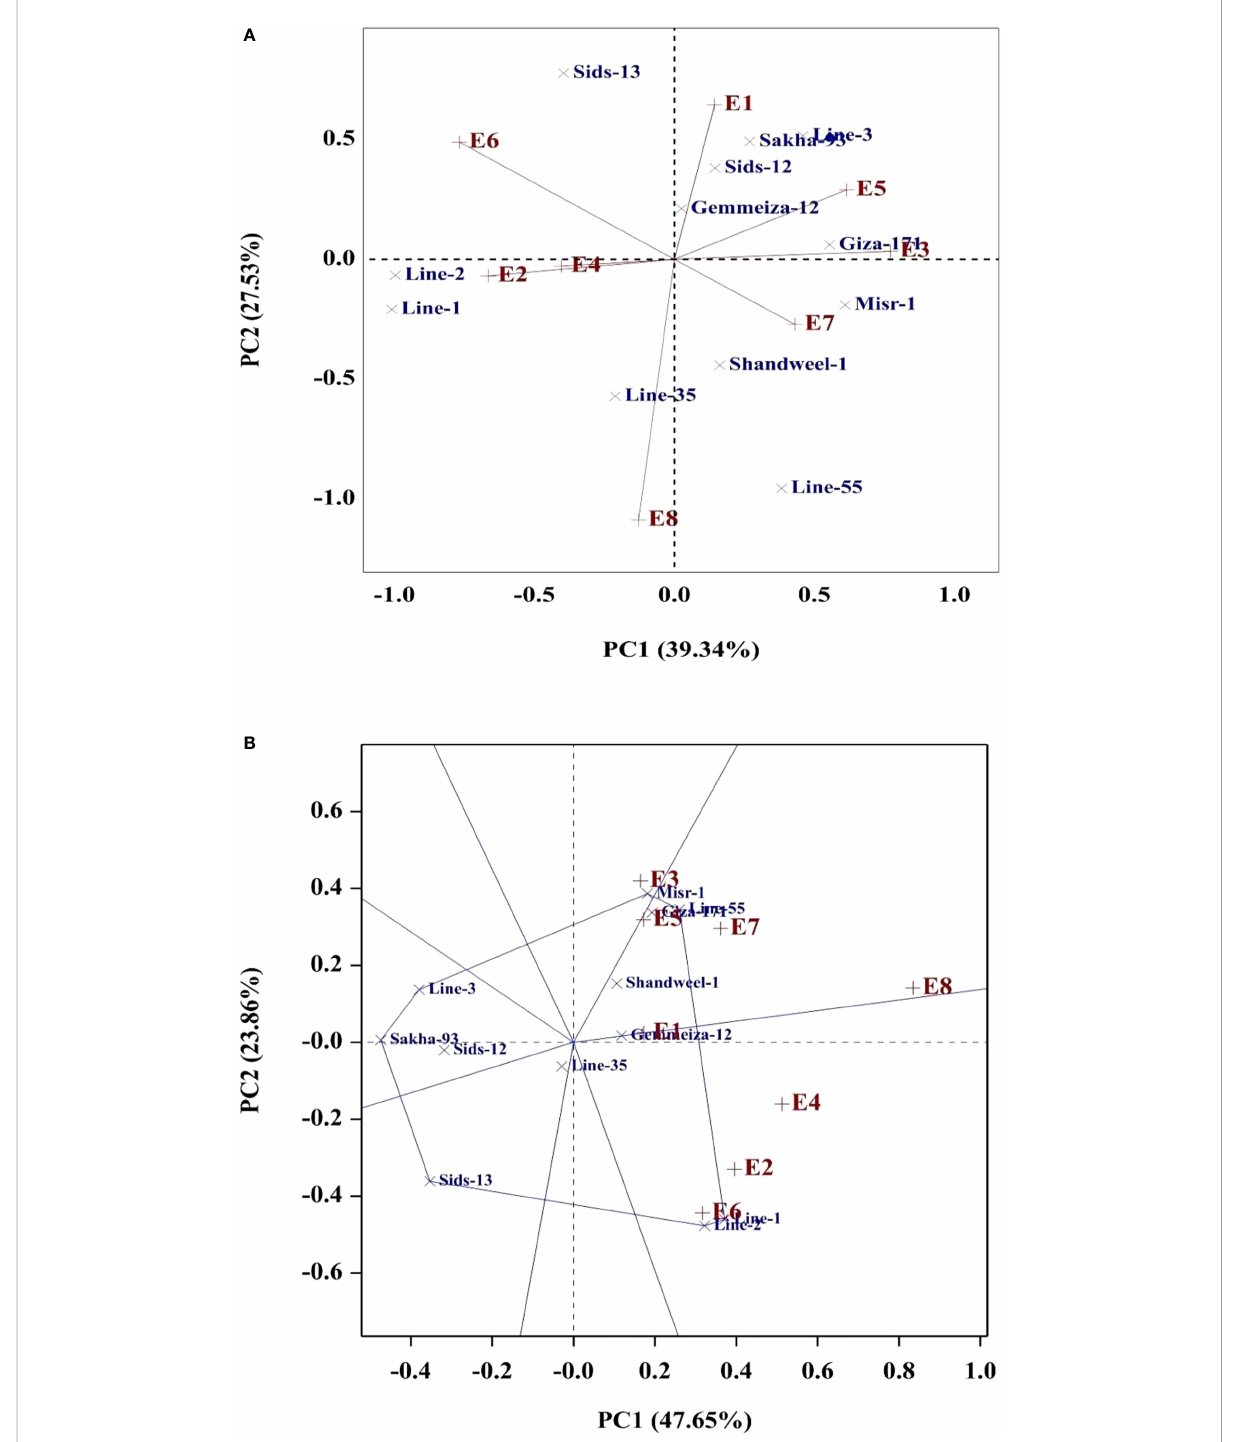
FIGURE 3 AMMI (A) and GGE (B) biplots for grain yield of the evaluated twelve bread wheat genotypes in eight environments (E1-E8) which are explained in Table